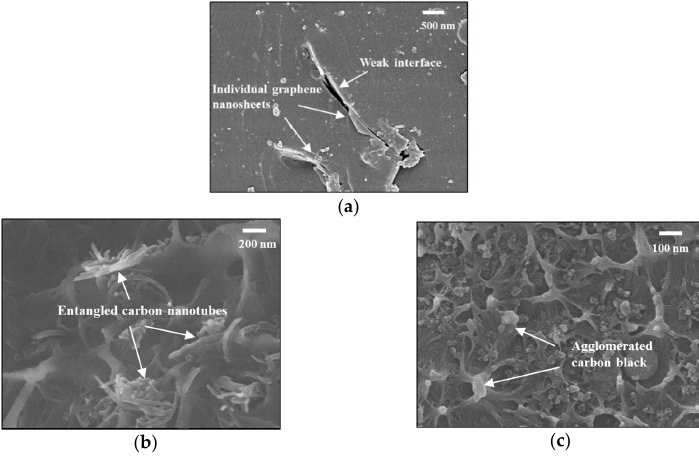
Figure 4. SEM micrographs of the cryo-fractured surfaces of the hybrid with different types of nanoparticles: ( a ) graphene, ( b ) nanotube, ( c ) carbon black.